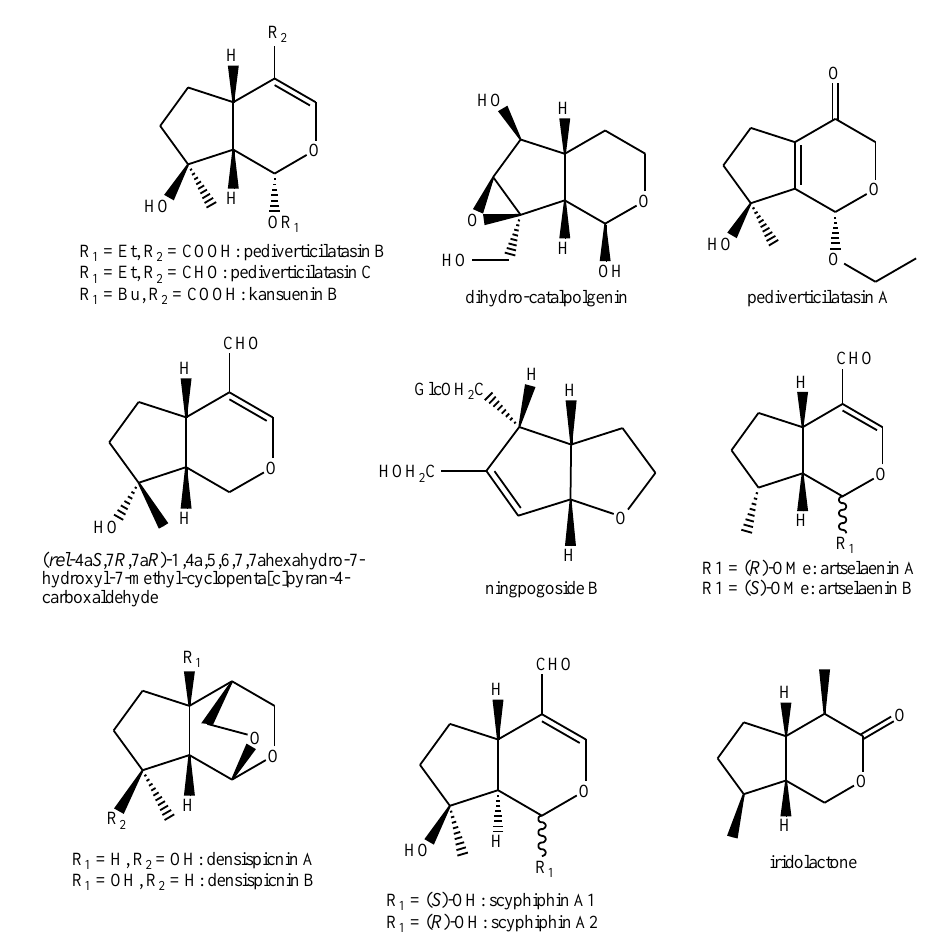
Figure 17. Iridoids identified in Pedicularis species—part 3. Plants 2019 , 8 , x FOR PEER REVIEW